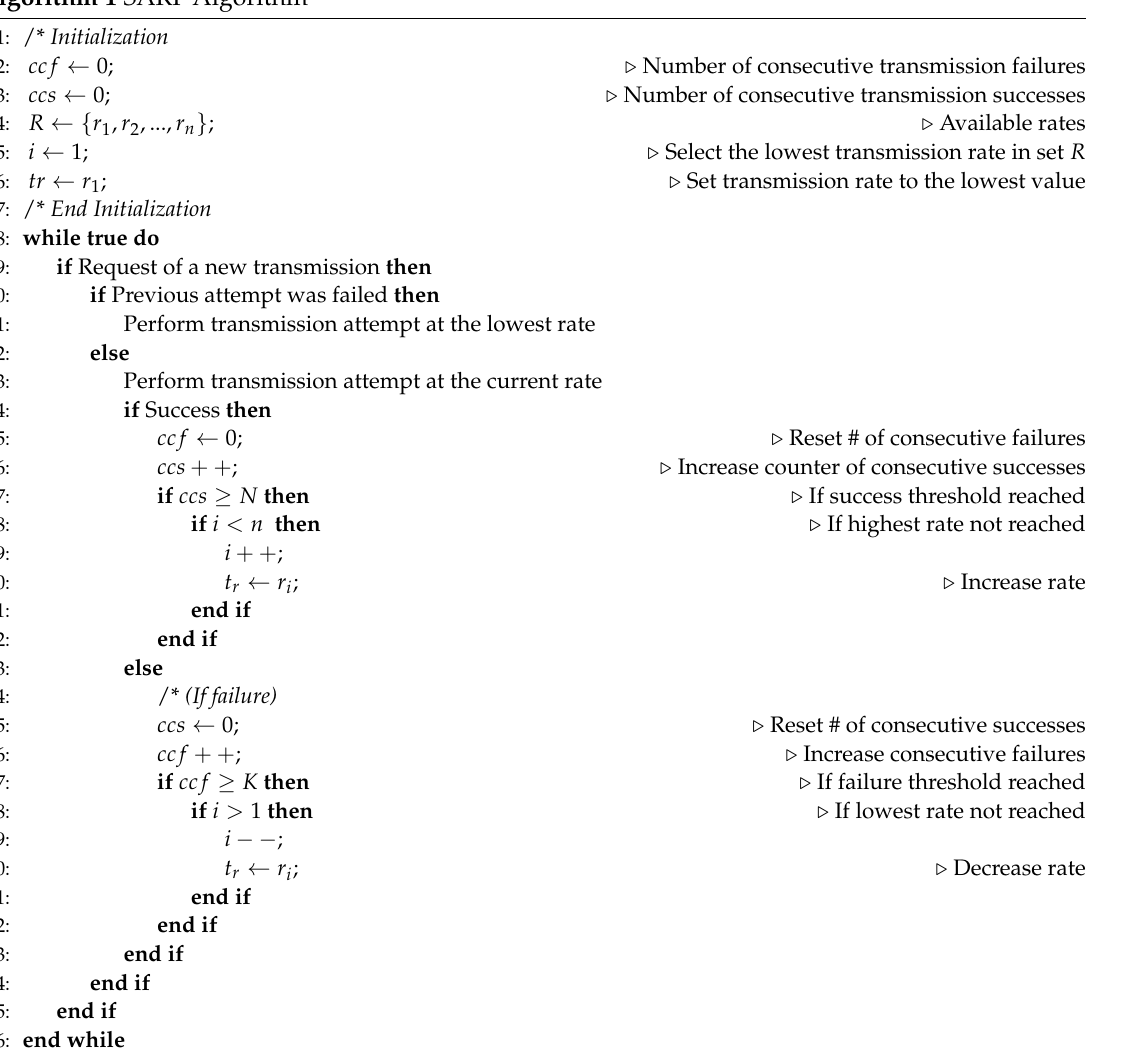
Algorithm 1 SARF